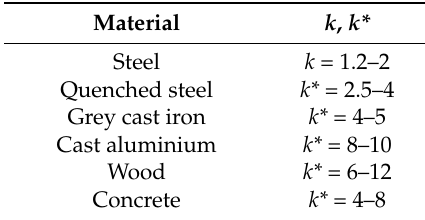
Table 6. Degree of safety for different materials.